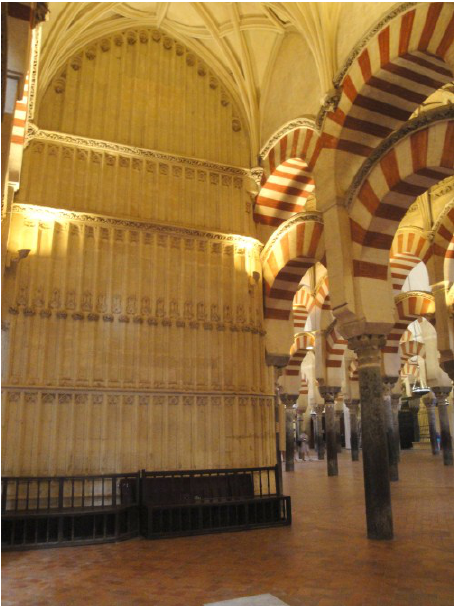
Figure 4. Hernan Ruiz I. Exterior of the chancel to the South. Mosque-Cathedral (Cordoba). Photo took by author.